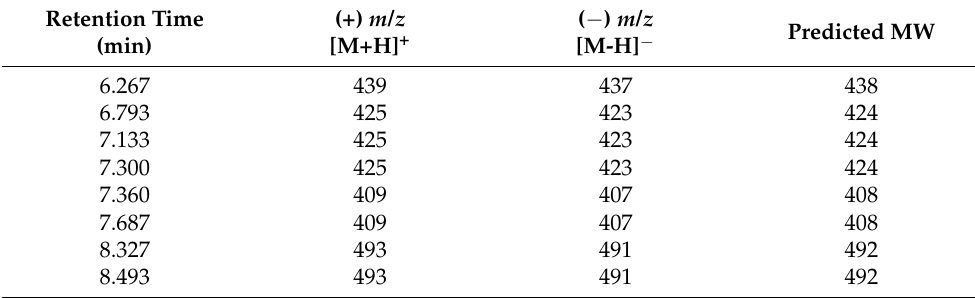
Table 1. Predicted molecular weight (MW) of the α -glucosidase ligands.